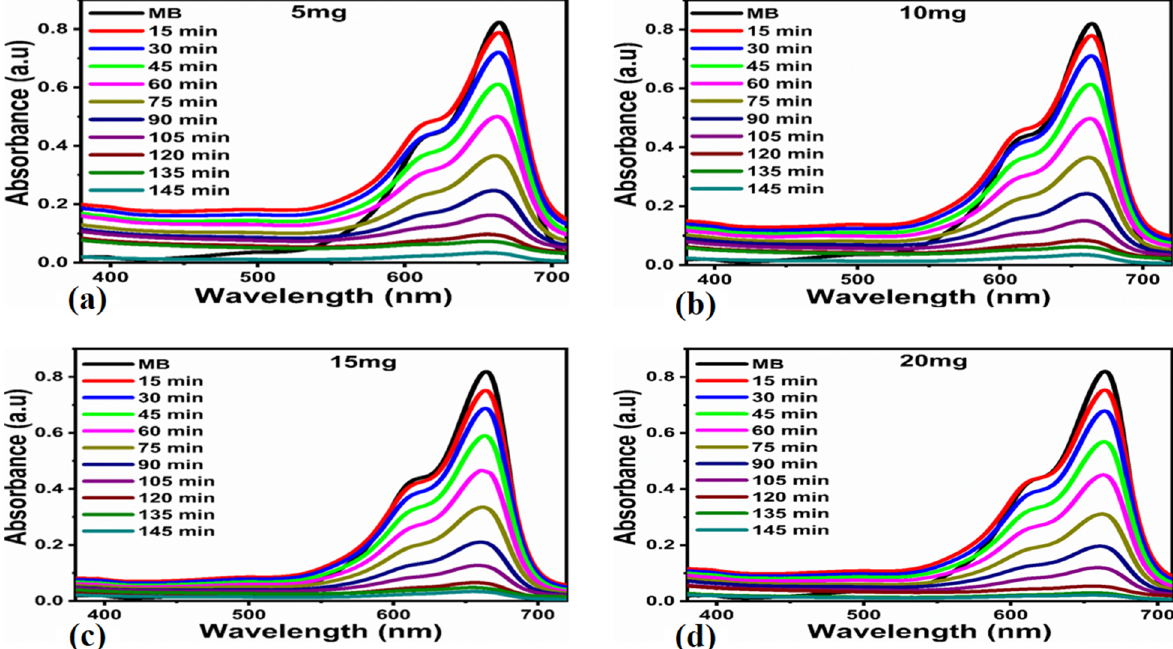
Figure 7. Low concentration absorption spectra under UV irradiation for psyllium-added ZnO with various concentrations of 5 mg ( a ), 10 mg ( b ), 15 mg ( c ), and 20 mg ( d ).